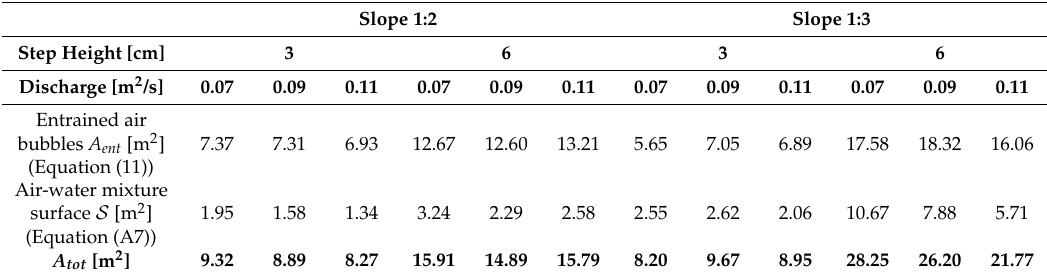
Table 2. Total air-water interface for all configurations. Slope 1:2 Slope 1:3 3 6 3 6 Step Height [cm]